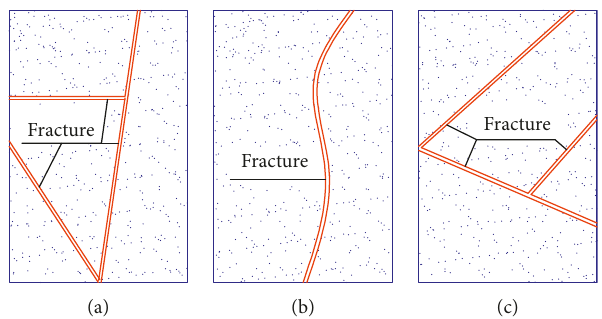
Figure 4: Sketch map of three rock samples with different fracture distributions: (a) I; (b) II; (c) III.